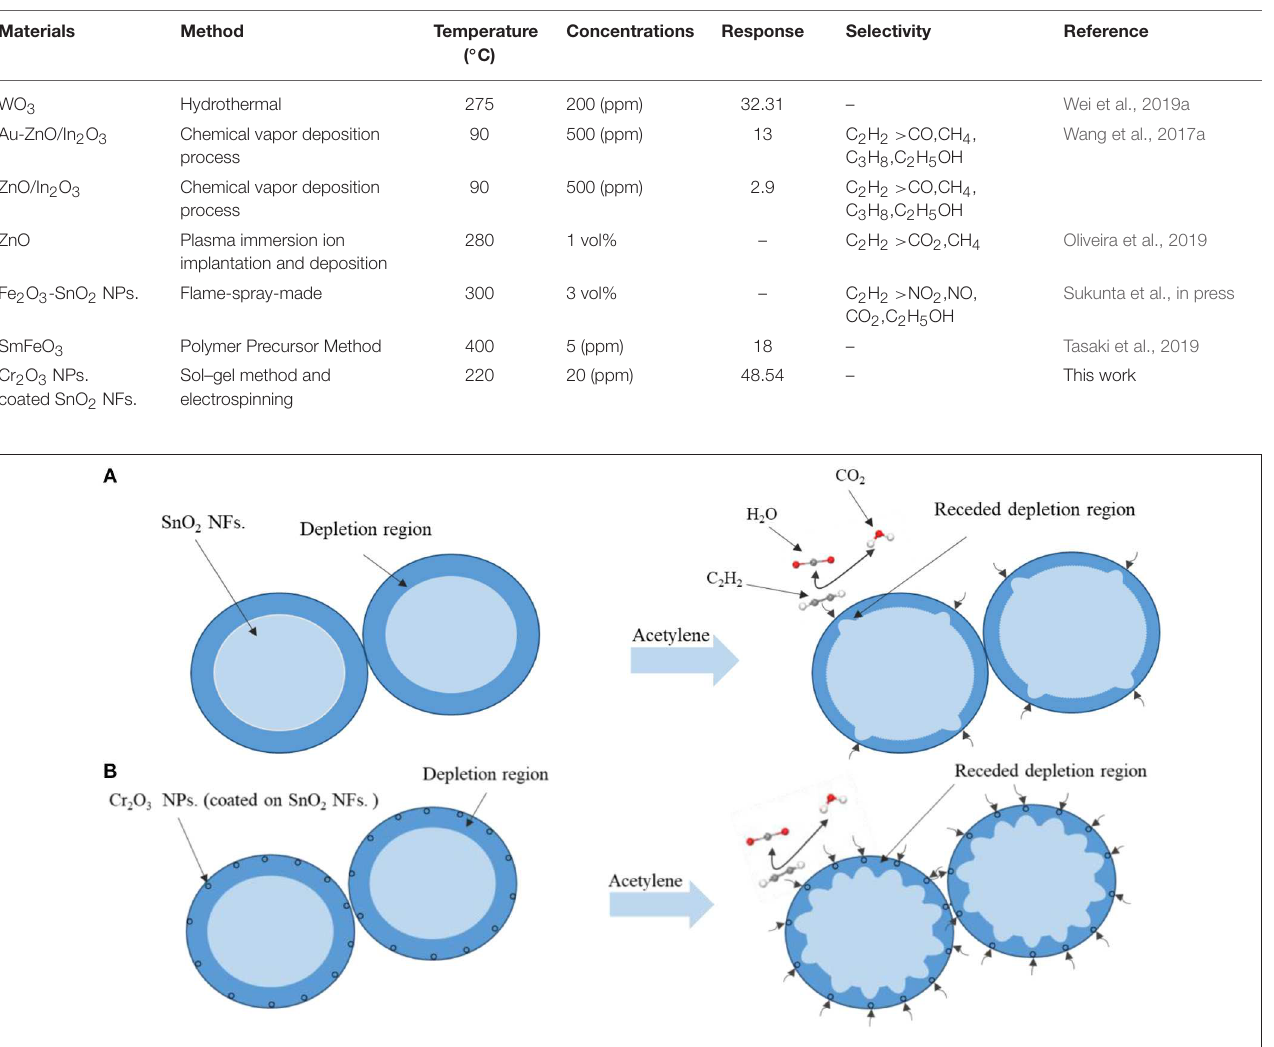
Frontiers in Materials |